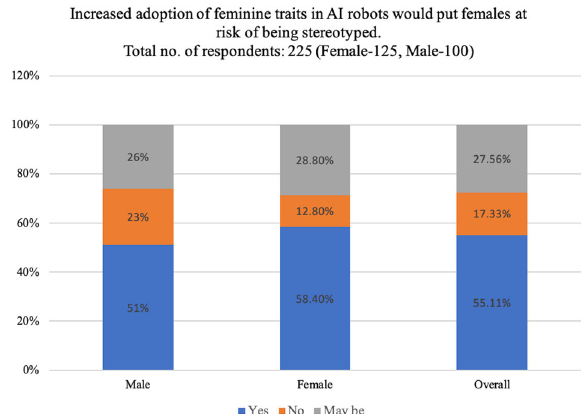
Fig. 16 Increased adoption of feminine traits in AI robots would put females at risk of being stereotyped. Total no. of respondents: 225 (Female: 125, Male: